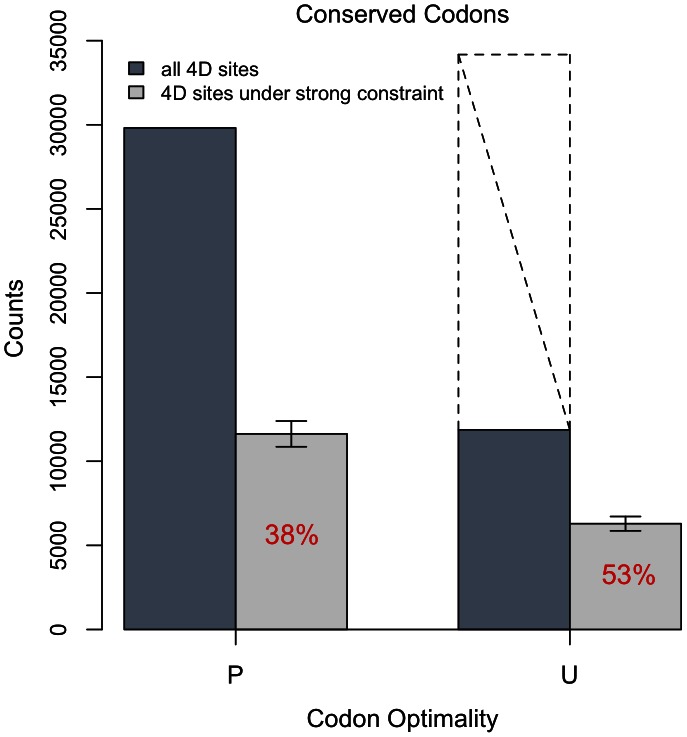
Codon optimality versus constraint in conserved codons.Codons are conserved from D. sechellia-D. grimshawi (excluding D. willistoni). The conserved codons were separated into those that were ancestrally preferred (P) and those that were ancestrally unpreferred (U) using polarization with the D. sechellia-D. grimshawi (excluding D. willistoni) outgroup. 10 bootstraps were done within each class. Error bars represent the s.e. of the estimates. The dark bars represent the counts of all sites that fall into each class while the light bars represent the number of sites estimated to be under strong constraint via the bootstrap procedure. The dashed line indicates what the count of total unpreferred conserved codons would have been had unpreferred 4D sites been conserved to the same extent as preferred 4D sites in otherwise conserved amino acids, i.e. the dashed line represents the proportion of U:P in all conserved amino acids. More than half (53%) of those unpreferred codons that are conserved across the ten Drosophila species are under strong purifying selection in D. melanogaster; 38% of preferred conserved codons are under strong selection.